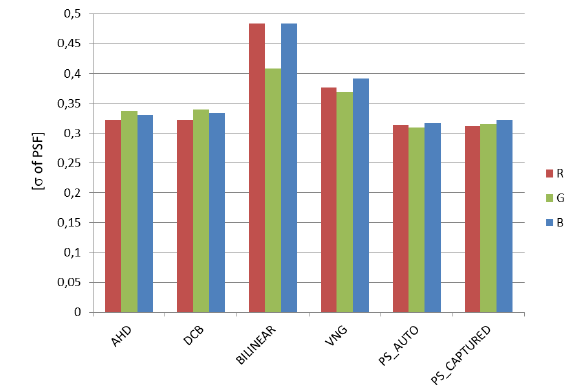
Figure 5. Comparison of different demosaicing methods in terms of (effective) image resolution / resolving power (PSF in pixel).